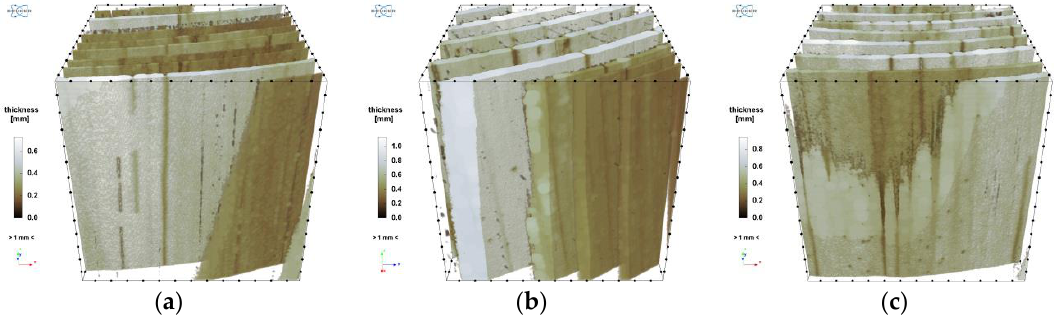
Figure 20. Distribution of local thickness of later growth rings: ( a ) sample “1” ; ( b ) sample “2” ; ( c ) sample “3”. Table 11. Summary of analysis of micro-computed tomography images.